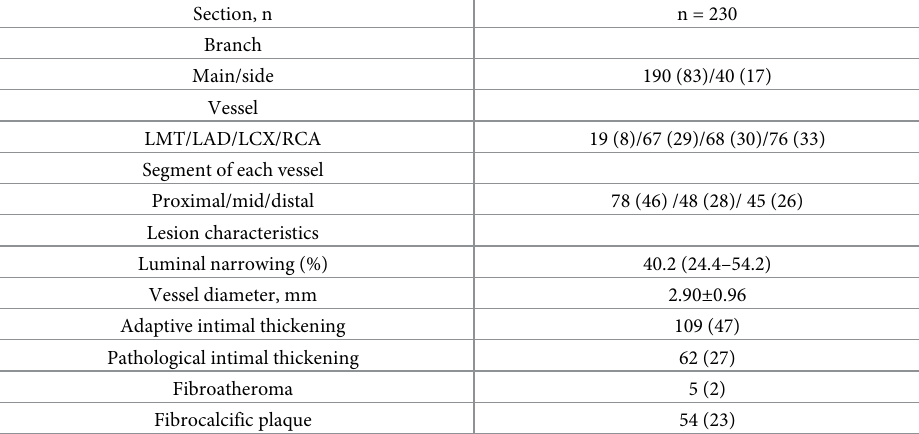
Table 1. Patient and lesion